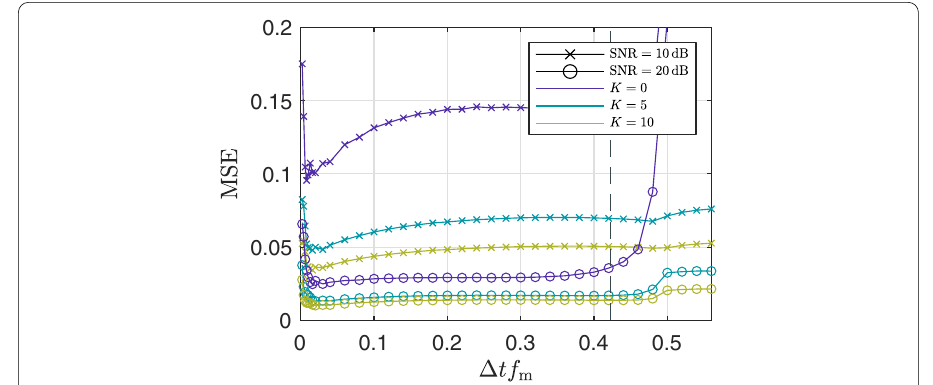
Fig. 8 Influence of the sampling period (cid:31) t on the MSE of the prediction. F = 10dB , M = 25 , N = 128 and = 0.1 ; the dashed line is an empirical value for the coherence time [6] t f p m